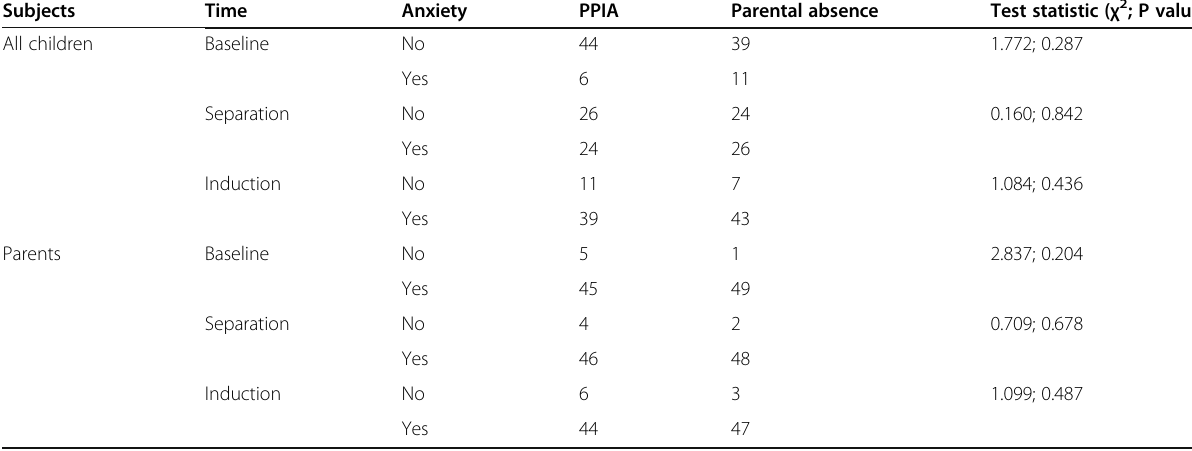
Table 4 Comparison of proportion of children and parents with anxiety Subjects